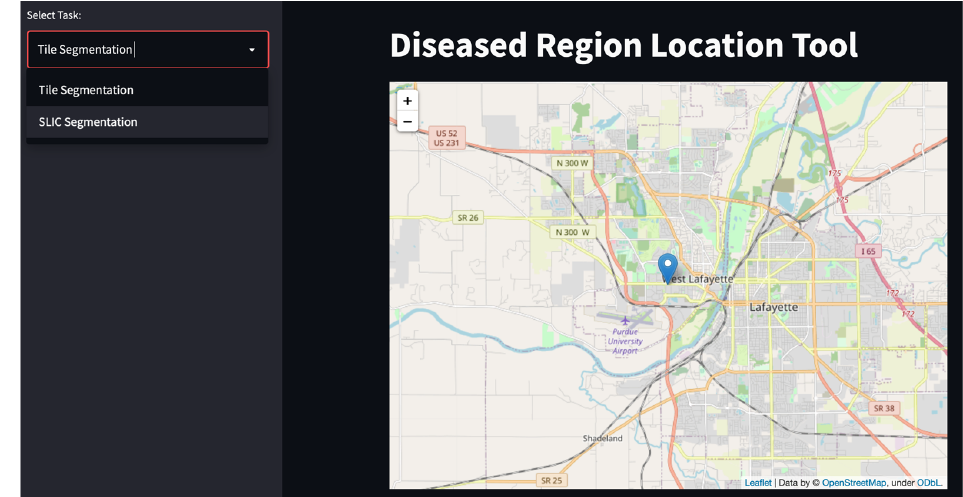
Figure 10. Home page of the GeoDLS web application.